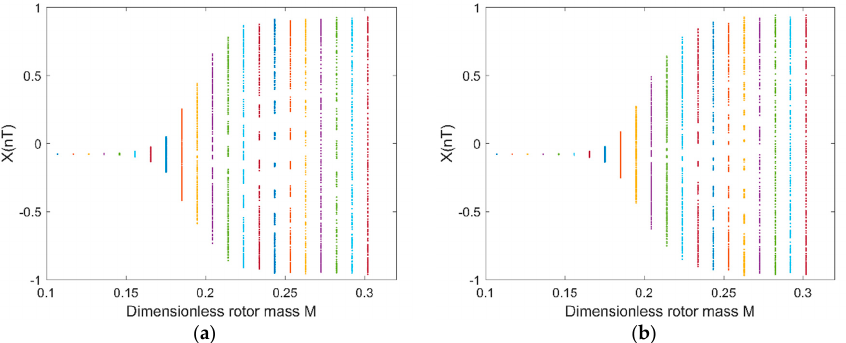
Figure 13. Rotor center trajectory at F e = 0.0987, M = 0.2825 ( a ) without considering the UMF; ( b ) with considering the UMF.